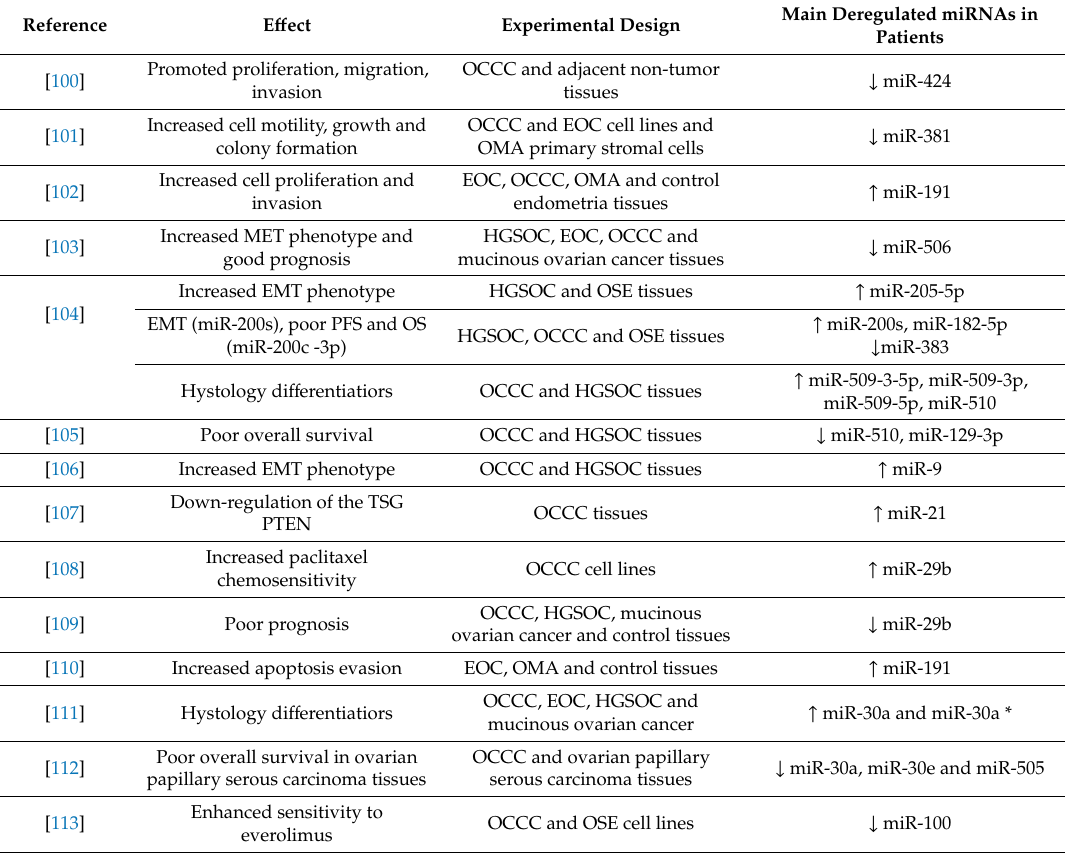
Table 3. Deregulated miRNAs in selected studies in